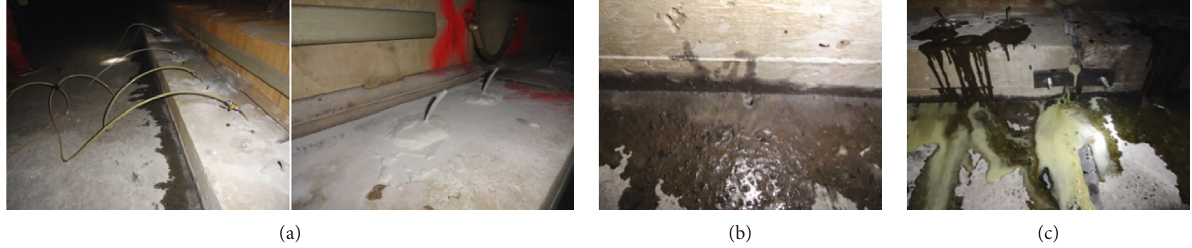
Figure 7: Mud pumping reinforcement process based on the injection of the LVER. (a) Grouting pipes. (b) Water squeezed out. (c) Mixed slurry flowing